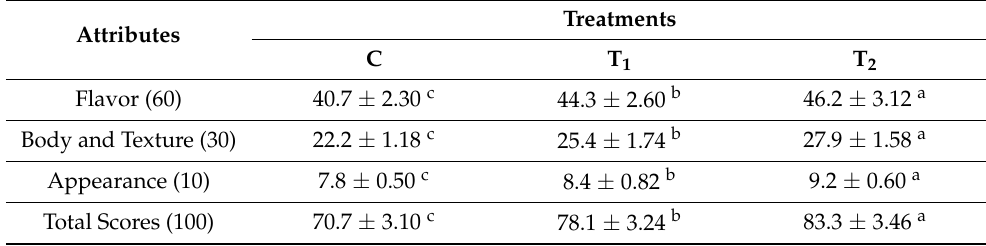
Table 3. Sensory properties of fermented camel milk containing pumpkin seed milk.